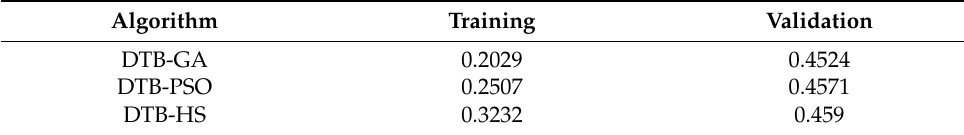
Table 5. Results for metric index in hybrid algorithms.